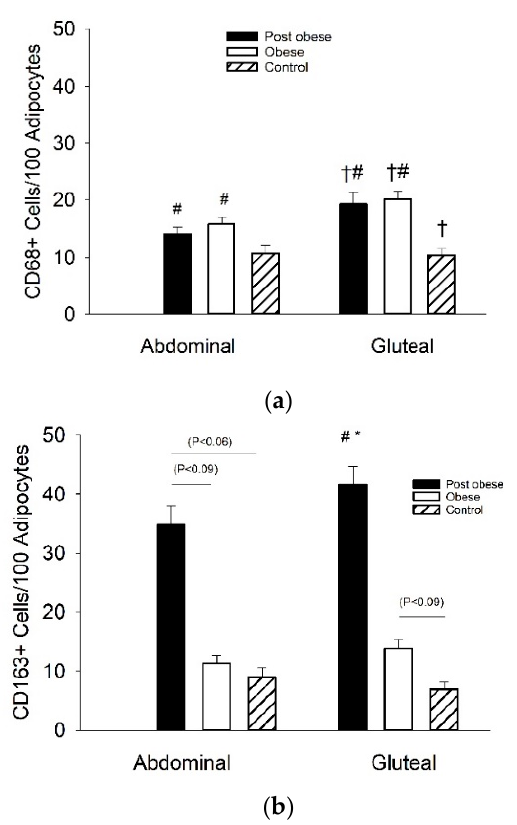
Figure 2. Adipocyte macrophage markers CD68 + ( a ) and CD163 + ( b ) in subcutaneous abdominal ( n = 7, n = 8, n = 9 and n = 7, n = 8, and n = 9, respectively) and gluteal ( n = 8, n = 9, n = 10 and n = 7, n = 8, n = 10, respectively) depots from Post obese, Obese and Control male subjects, respectively. Data are mean ± SEM. *: ( p < 0.05) vs. Obese; #: ( p < 0.05) vs. Control; †: ( p < 0.05) Abdominal vs. Gluteal.